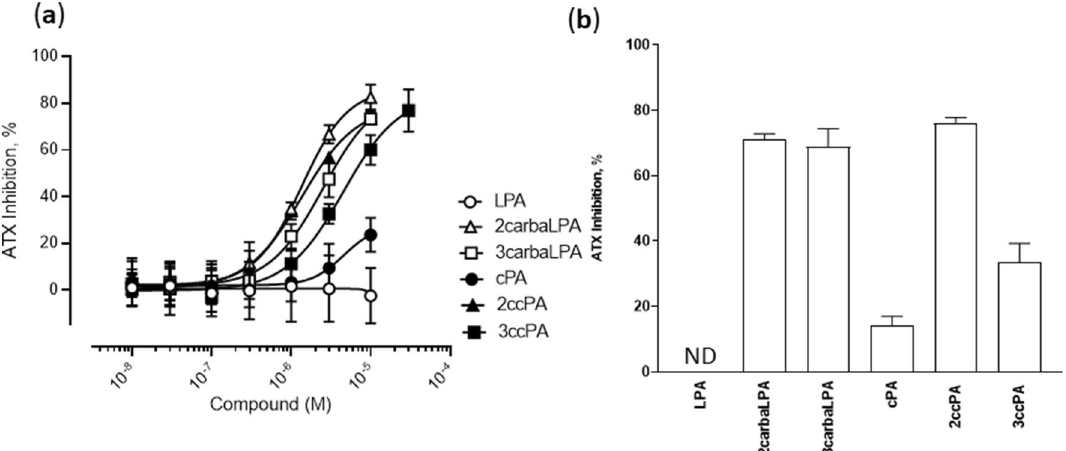
Figure 5. Inhibition of lysophospholipase D activity of autotaxin (ATX) by cyclic phosphatidic acid (cPA) analogues. ( a ) Concentration–response curves for the inhibition of ATX activity as measured by the hydration of the substrate lysophosphatidylcholine (LPC) using choline oxidase and peroxidase. LPC 16:0 (final concentration: 300 µM, above its critical micellar concentration [CMC]), human recombinant ATX (final concentration: 50 nM), and various concentrations of cPA analogues were used for incubation with 4-aminoantipyrine, TOOS (final concentration: 0.05% (w/v) each), choline oxidase and peroxidase (final concentration: 10 U/mL each) in the ATX assay buffer. The absorbance at a wavelength of 555 nm was measured at 0 and 2 h incubation at 37 °C. Inhibition was calculated as percentage (%) of reduction in absorbance compared with absorbance in the vehicle control (without cPA analogues) after subtraction of the value measured at time 0. Data are represented as mean ± standard deviation (n = 3–4 samples). ( b ) Inhibition of ATX activity measured by lysophosphatidic acid (LPA 16:0) production via liquid chromatography coupled to triple quadrupole mass spectrometry (LC-QqQ). The substrate LPC 16:0 (final concentration: 300 µM) was incubated with human recombinant ATX (final concentration: 50 nM) and cPA analogues (final concentration: 10 μM) for 2 h at 37 °C. The ATX product, LPA 16:0, was quantified by LC-QqQ. Inhibition was calculated as percentage (%) of reduction in LPA production compared with LPA production in the vehicle control (without cPA analogues). Data are represented as mean ± standard deviation (n = 5–6 samples).